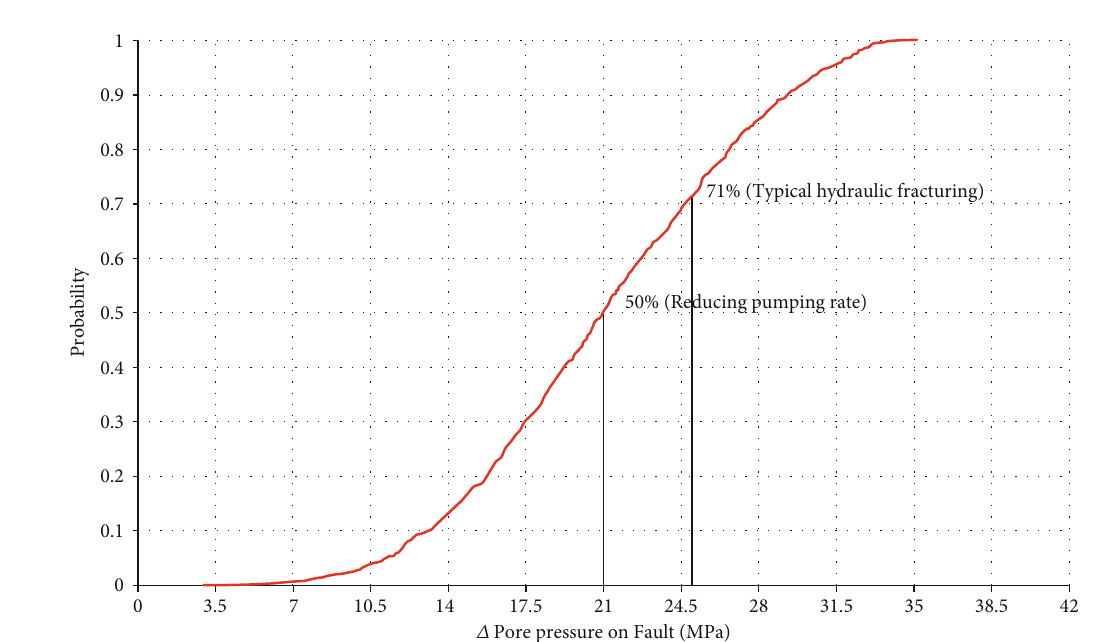
Figure 12: Probabilistic distributions of geomechanical uncertainties for the fault #1.